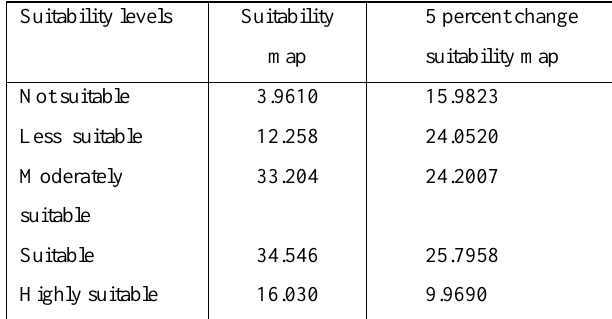
Table 6: Percentage of suitability areas from sensitivity